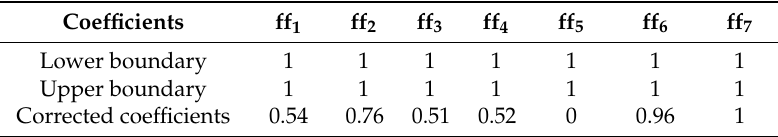
Table 21. The boundaries and correction results of the state variables coefficients.